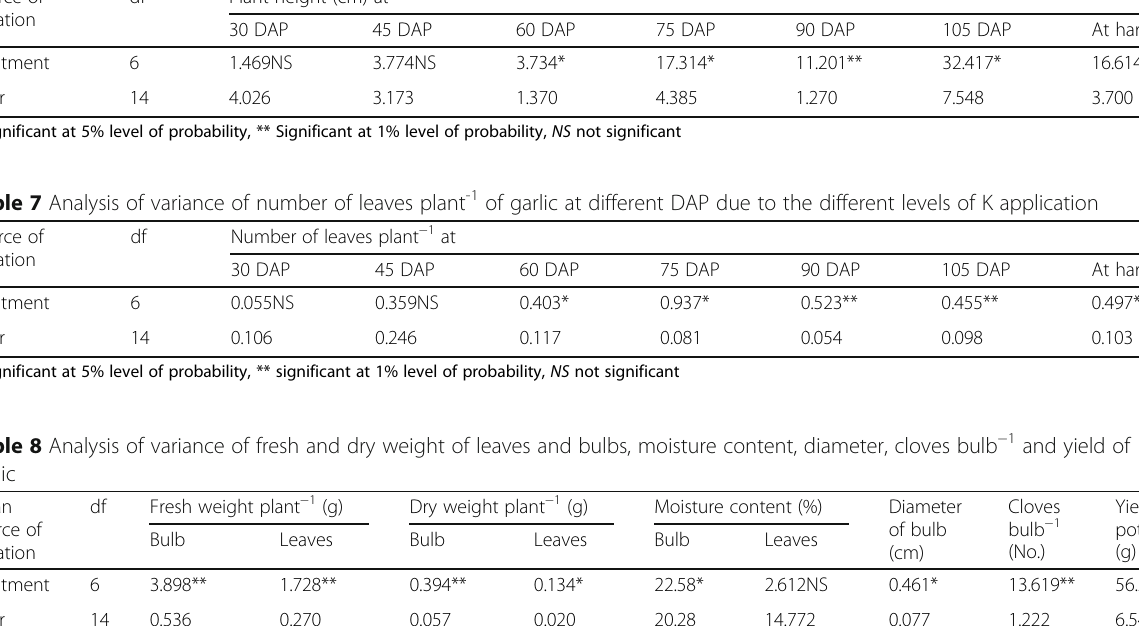
Table 6 Analysis of variance of plant height of garlic at different DAP due to the different levels of K application Source of variation